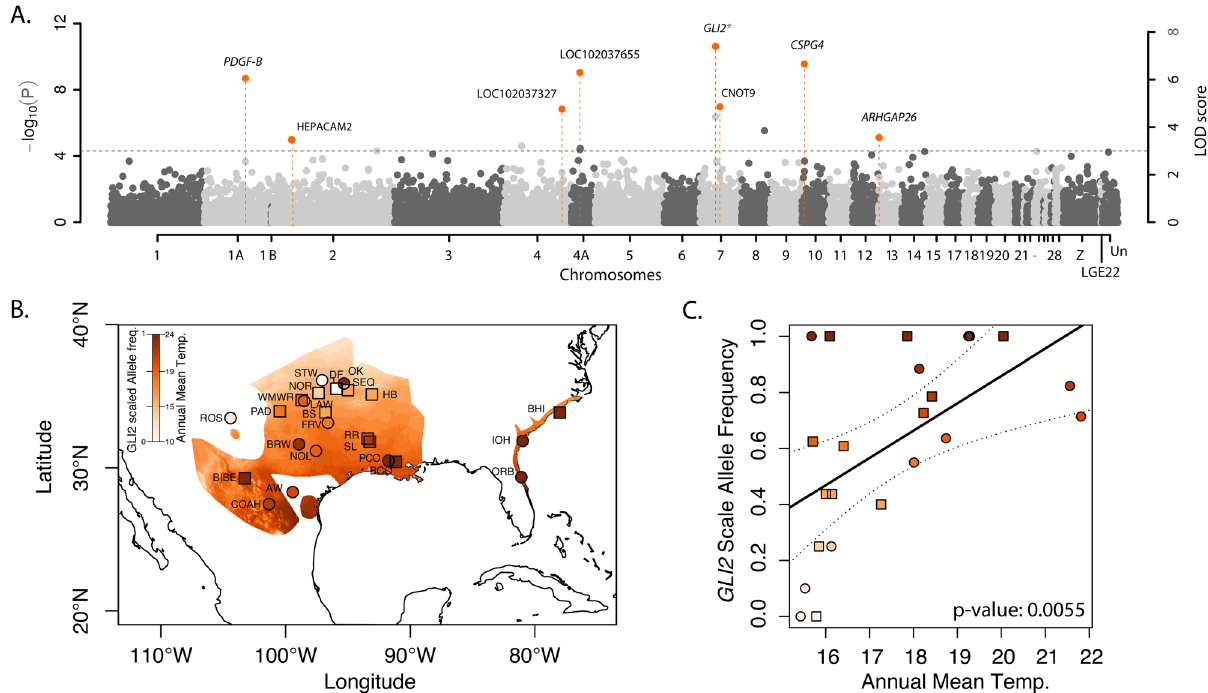
Figure 3. ( A ) Manhattan plot of genome-wide association results of molt-migration behavior grouping in Painted Buntings using the mrMLM v4.0 software. Orange highlights the candidate genes around quantitative trait nucleotides (QTNs). Alternating grey and black colors correspond to alternating chromosomes. ( B,C ) Correlations between allele frequency and BIO01 (Annual Mean Temperature) for top ranking SNP in GLI2 . Samples genotyped by RAD-Seq are represented as squares, and samples genotyped with Fluidigm assays are shown as circles. Site abbreviations used on the map in panel B and additional sample information are reported in the Supplementary Material, Table